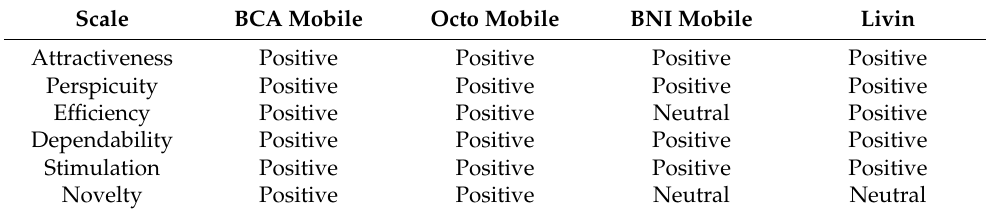
Table 2. The interpretation of the mobile banking application UX.